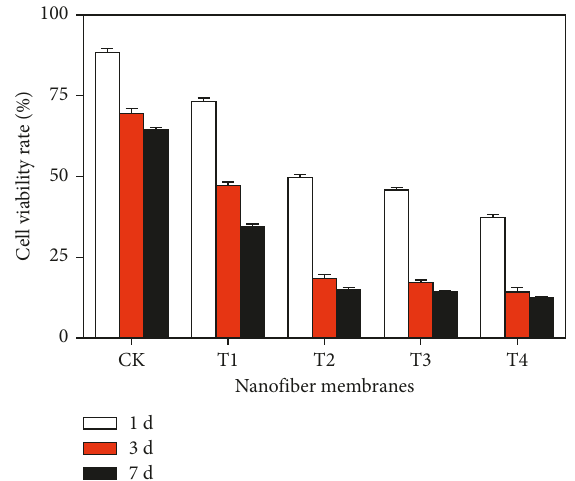
Figure 6: In-vitro cytotoxicity of PVA/PBC/GO fiber membrane on A549